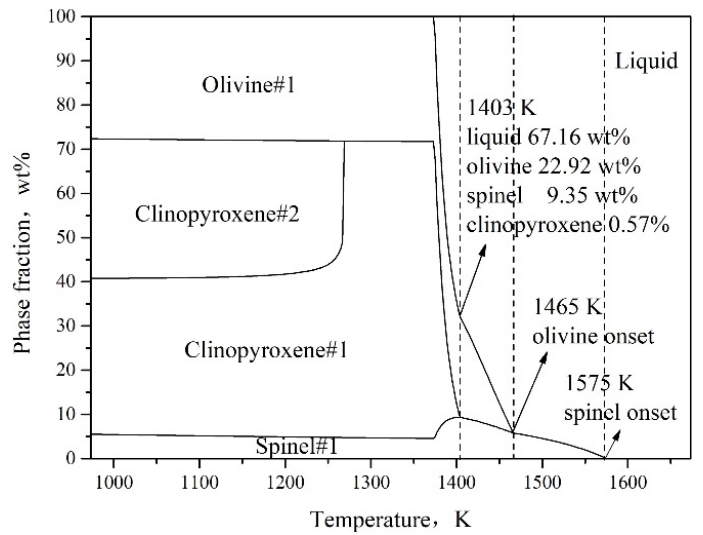
Figure 5. Calculated cooling phase equilibrium at 973–1673 K (Fe/SiO 2 = 1.0, Fe 2 O 3 = 8